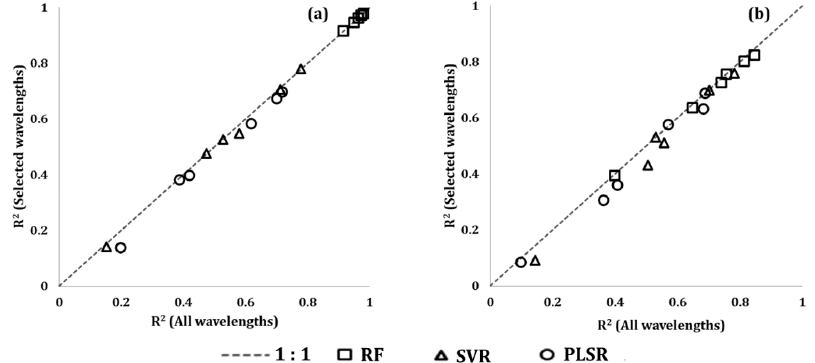
Figure 6. Comparison of R 2 values for the full and selected wavelength models for the ( a ) calibration set and ( b ) validation set.